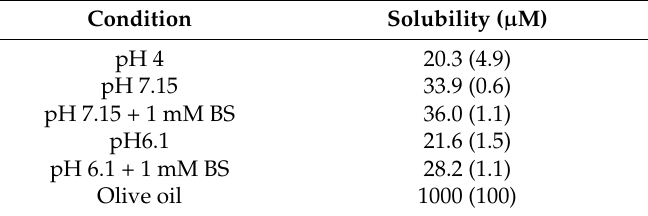
Table 2. Solubility of quercetin under different conditions in DPBS at 37 ◦ C.